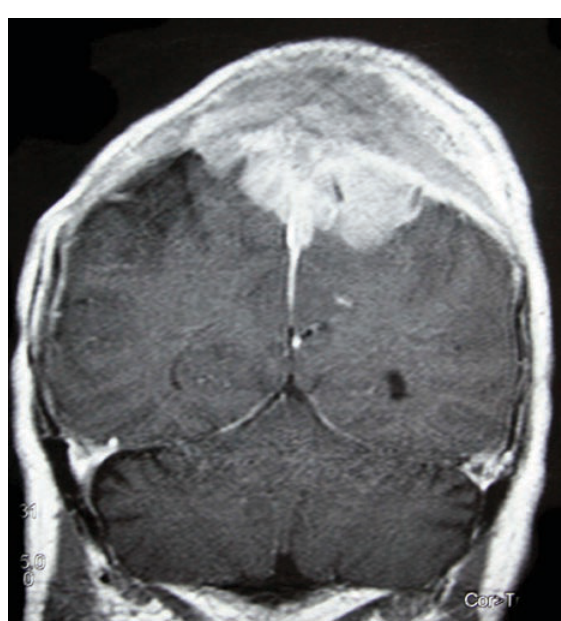
Figure 1. Preoperative coronal T1-weighted MRI study demonstrating a parasagittal infiltrative frontoparietal mass accompanied by bone hypeostosis.